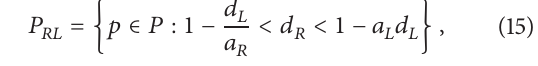
Figure 7: 1D bifurcation diagram of map and 𝑑 ∈ (𝜑 𝑅 ,1) , where 𝜑 𝑅 ≈ 0.167 . The related parameter path is indicated in Figure 6 by the horizontal line with an arrow.